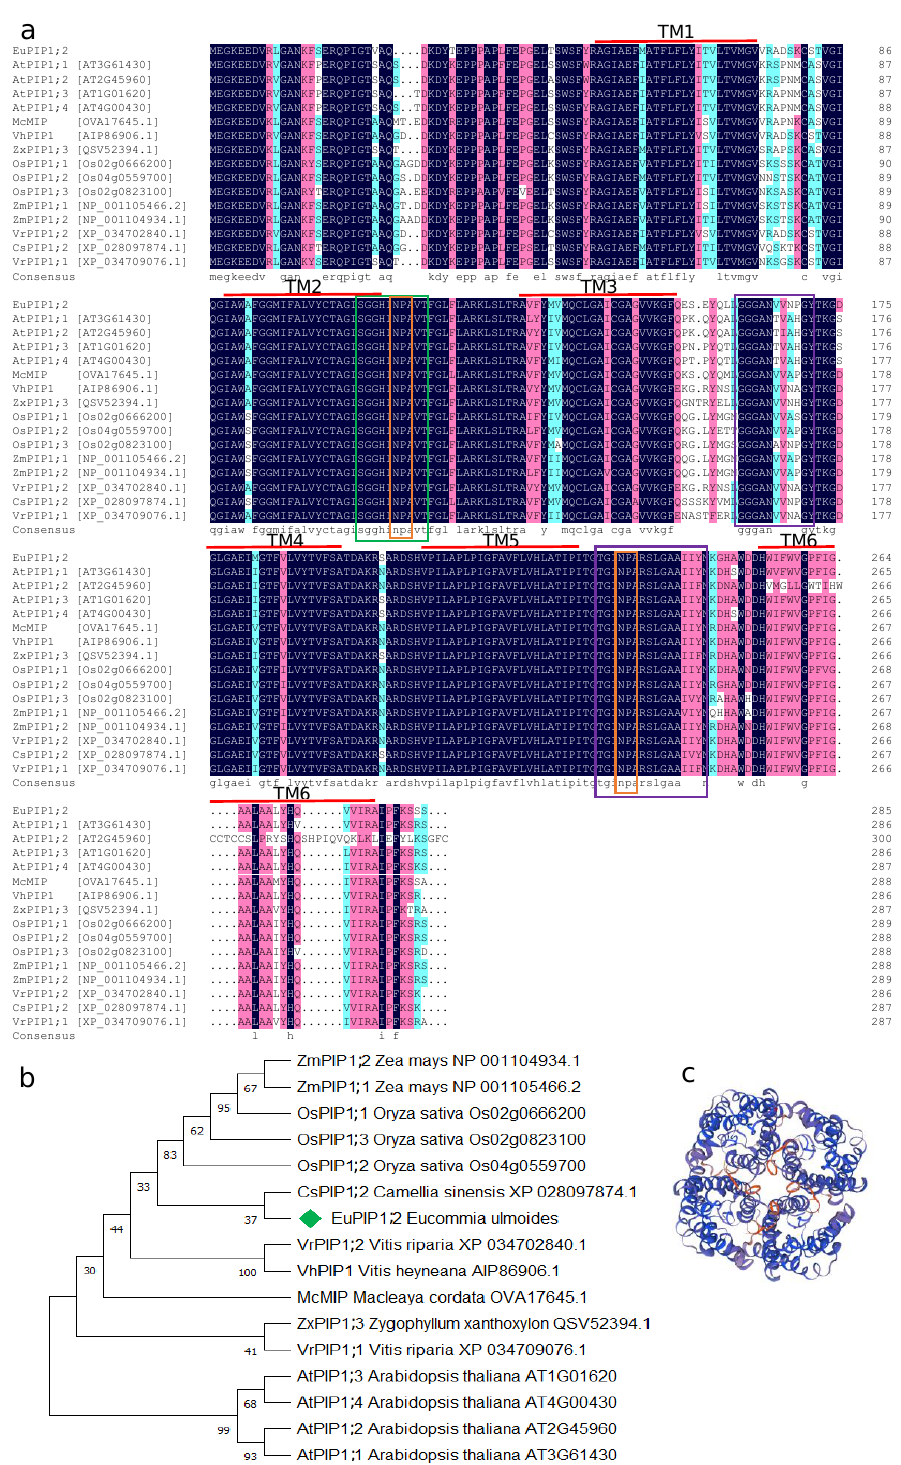
Figure 2. Multiple alignment and phylogenetic analysis of EuPIP1;2 with other plant PIP proteins. ( a ) The conserved amino acid residues in all proteins. The MIP family intrinsic protein-specific motif “SGGHINPAVT” is enclosed in the green box, the plant PIP highly conserved sequences “GGGANVVNPGY” and “TGINPARSLGAAIIYN” are indicated by purple boxes, and two “NPA” motifs are enclosed in orange boxes. TM, transmembrane domain. ( b ) Phylogenetic analysis of EuPIP1;2 and PIP proteins from other plant species. ( c ) Prediction of the tertiary structure of